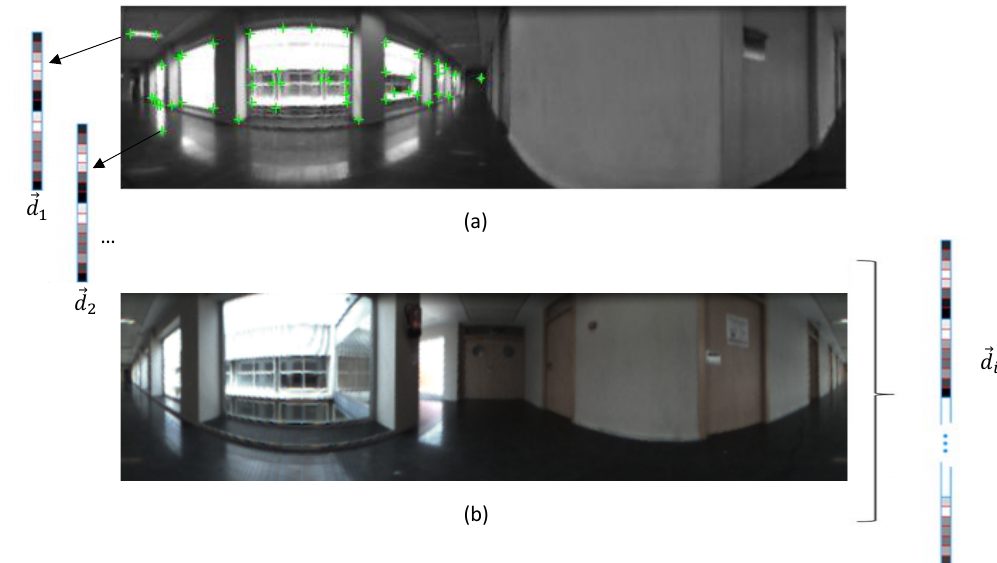
Figure 2. Two main methods to extract the most relevant information from the images for mapping and localization purposes. ( a ) Detection, description, and tracking of some relevant landmarks along a set of scenes. ( b ) Building a unique descriptor per image that contains information on its global